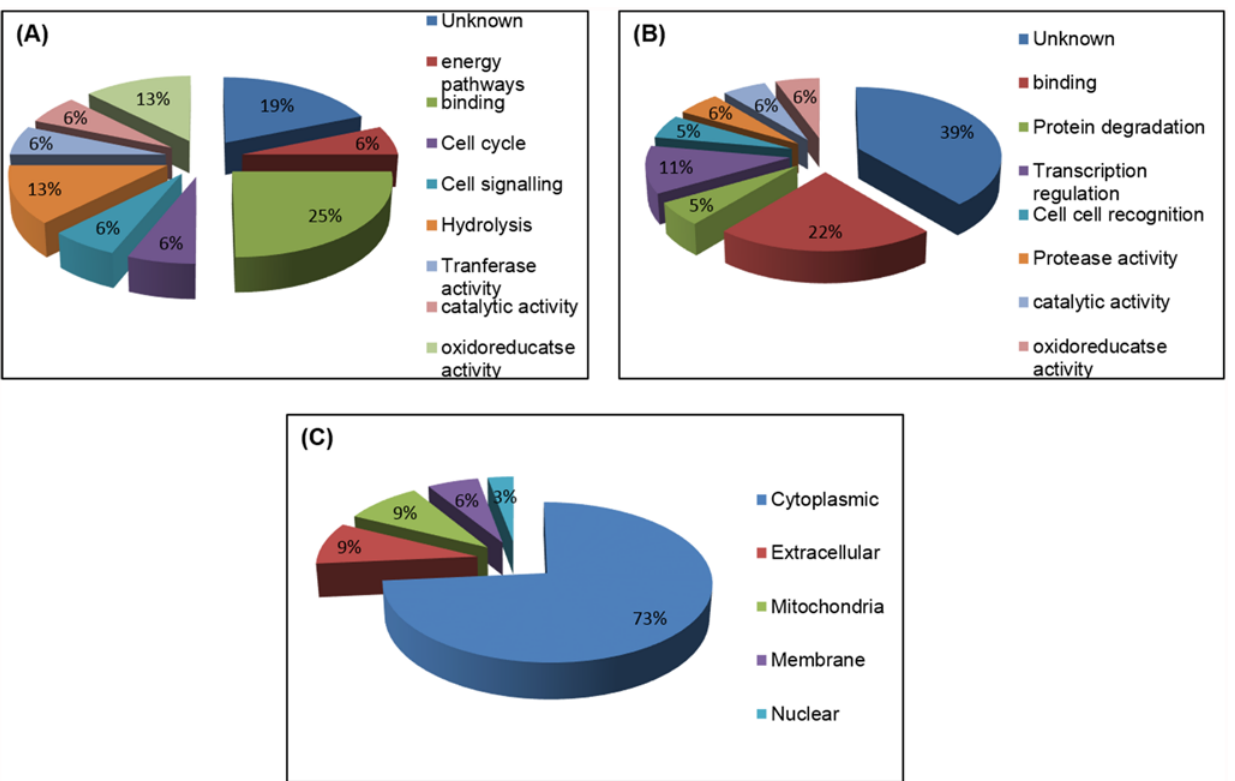
Fig 5. Illustration of identified upregulated & downregulated salivary proteins analyzed by gene ontology tool. (A) GO function of identified upregulated proteins. (B) GO function of identified downregulated proteins. (C) GO component of identified proteins.